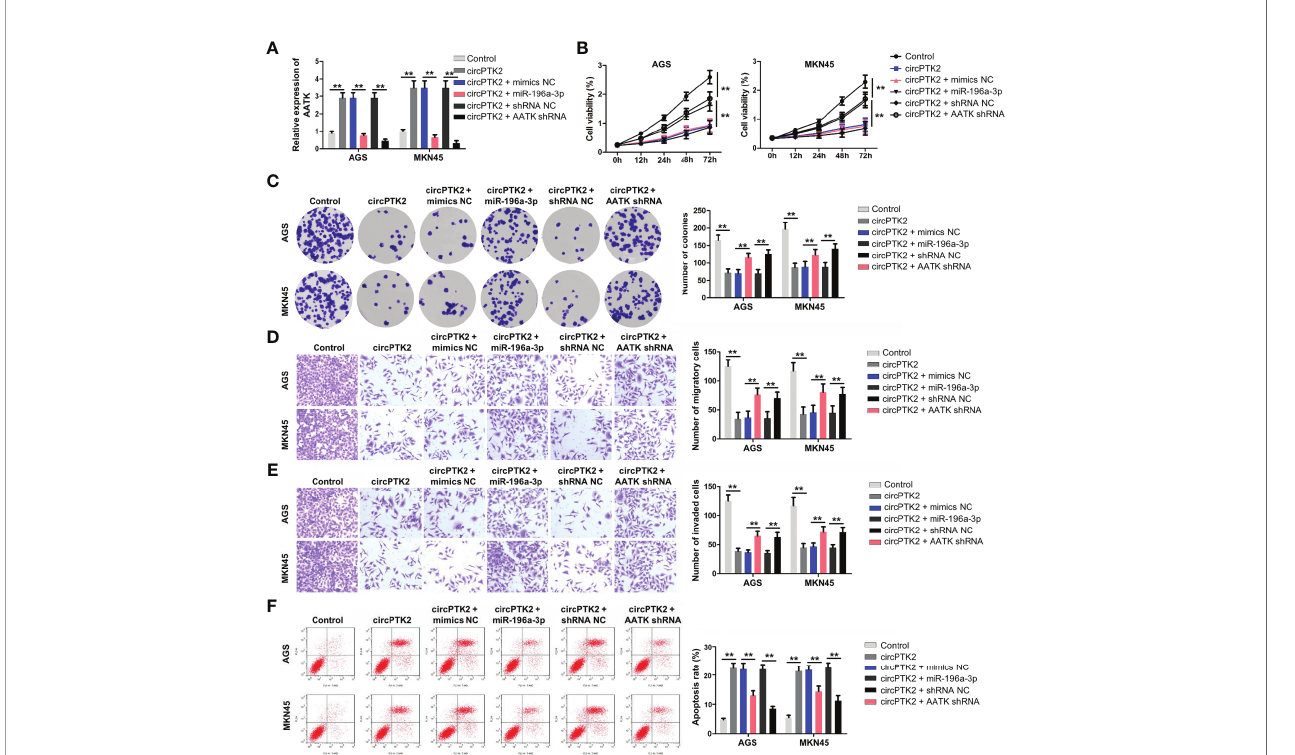
FIGURE 7 | Knockdown of AATK reverses the tumor-suppressing effect of circPTK2. AGS and MKN45 cells were treated with circPTK2, circPTK2 plus miR-196a- 3p mimics, or circPTK2 plus AATK shRNA. (A) RT-qPCR was used to detect the level of AATK in AGS and MKN45 cells. (B) Cell viability was measured by CCK-8 assay. (C) Cell proliferation was determined by colony formation staining assay. (D) Cell migration and (E) cell invasion were measured by transwell assays. (F) Cell apoptosis was measured by fl ow cytometry. ** p < 0.01. The signi fi cance between fi ve groups was analyzed by one-way ANOVA.